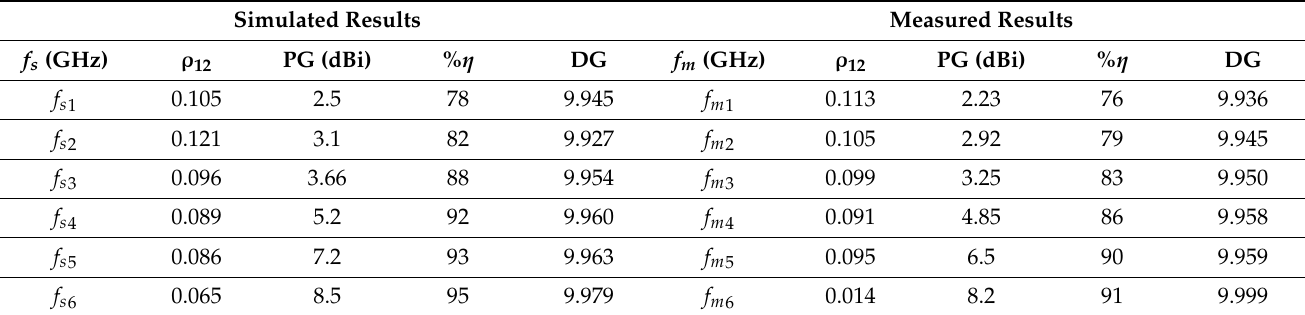
Table 2. ECC, (% η ), peak gain (PG), and diversity gain (DG).